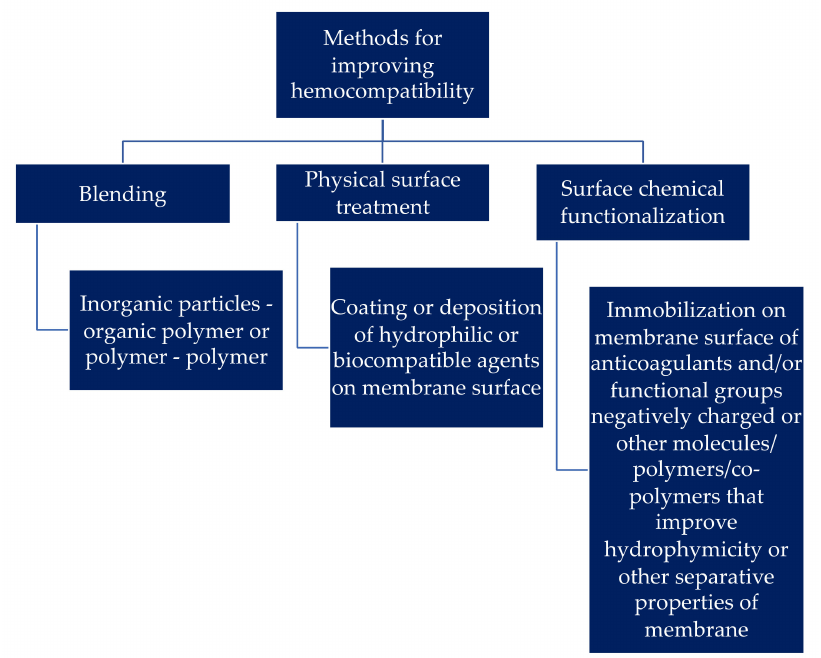
Figure 2. Schematic representation of most common methods for improving